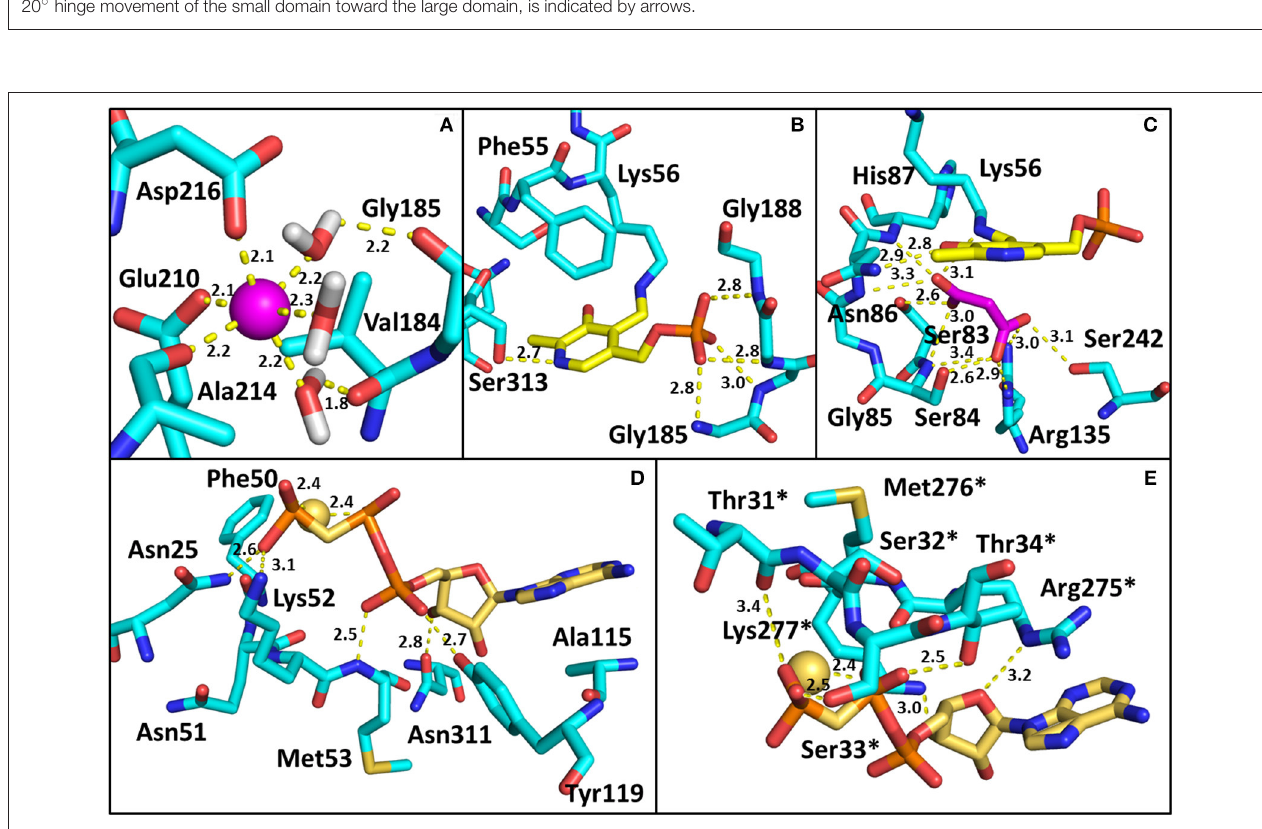
FIGURE 3 | Binding sites in SR. The amino acids involved in the interactions are reported as cyan sticks, and polar interactions are highlighted by yellow dotted lines. The PDB used are 3L6B (hSR, closed form) for panels (A–C) , and 1WTC (spSR with AMP-PCP) for (D,E) . (A) Divalent cation binding site in hSR. The cation (Mn 2 + ) is represented as a pink sphere; (B) PLP binding site in hSR; (C) Malonate binding site in hSR; (D) AMP-PCP binding site in spSR. The residues of the monomer in closer contact with the allosteric effector are reported. The positions of Asn25, Phe50, Asn51, Lys52, Met53, Ala115, Tyr119, and Asn311 in spSR correspond to His24, Phe49, Asn50, Lys51, Thr52, Ala117, Tyr121, and Asn316 in hSR, respectively; (E) residues of the second monomer involved in the interaction with AMP-PCP are reported. Asterisks indicate that the residues belong to the monomer on the opposite side of AMP-PCP. The positions of Thr31, Ser32, Ser33, Thr34, Arg275, Met276, and Lys277 in spSR correspond to Thr30, Ser31, Ser32, Ile33, Arg277, Met278, and Lys279 in hSR, respectively. Water molecules involved in the binding of SR with ligands are omitted for the sake of simplicity in all panels except (A) . All distances are within 3.4 Å.